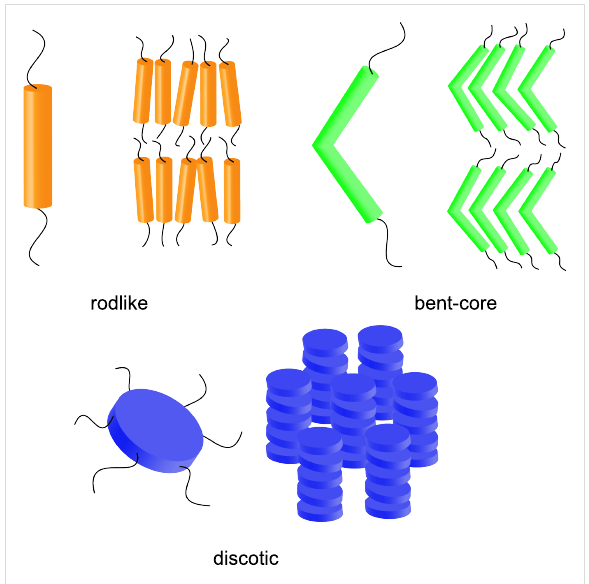
Figure 1: Three of the common molecular and supramolecular struc- tural motifs in liquid crystal chemistry: rodlike, bent-core and discotic